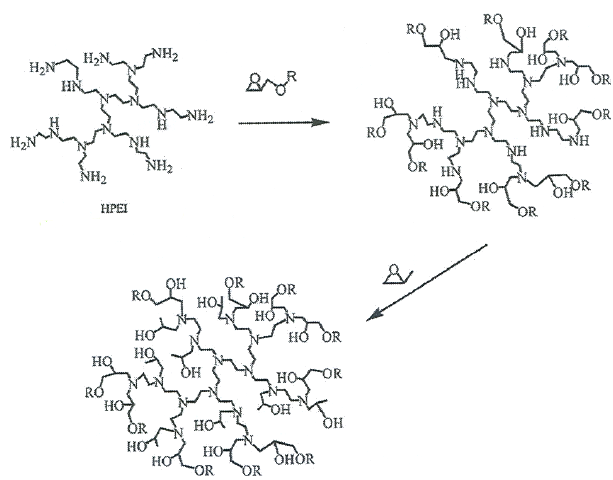
Figure 4. Schematic illustration of the curing reaction of the epoxy resin with HBPEI.